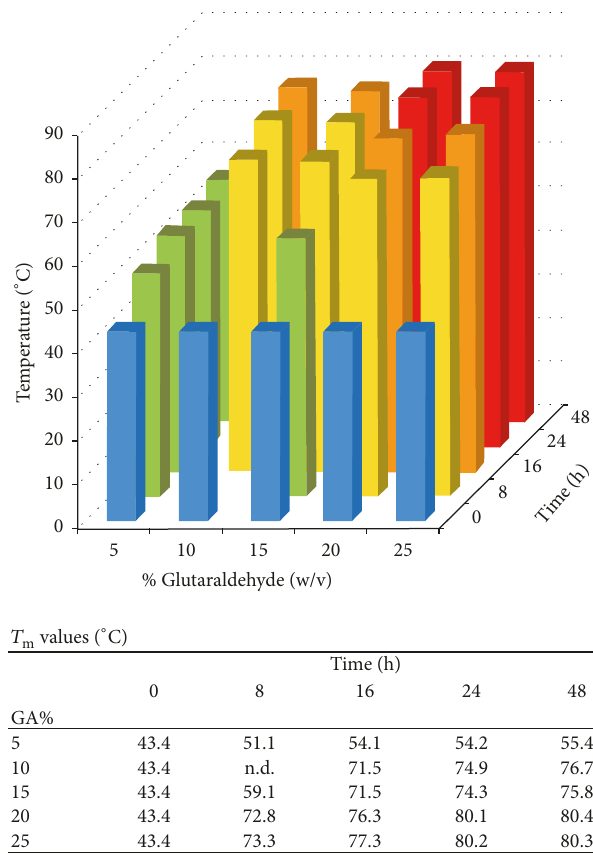
Figure 1: Bar diagram, showing the melting temperature, 𝑇 m , of collagen sponges treated with varying amounts of aqueous GA vapour for various time periods. Red bars indicate 𝑇 m > 80 ∘ C, orange bars indicate 75 ∘ C < 𝑇 m < 80 ∘ C, yellow bars indicate 70 ∘ C < 𝑇 m < 75 ∘ C, green bars indicate 50 ∘ C < 𝑇 m < 70 ∘ C, and blue bars indicate 𝑇 m < 50 ∘ C, as found for the average value of control untreated sponges. A single average 𝑇 m value for control untreated samples was obtained and this average value was used in each of the different % GA treatment series. 𝑇 m values are given below the diagram. n.d.: not determined.